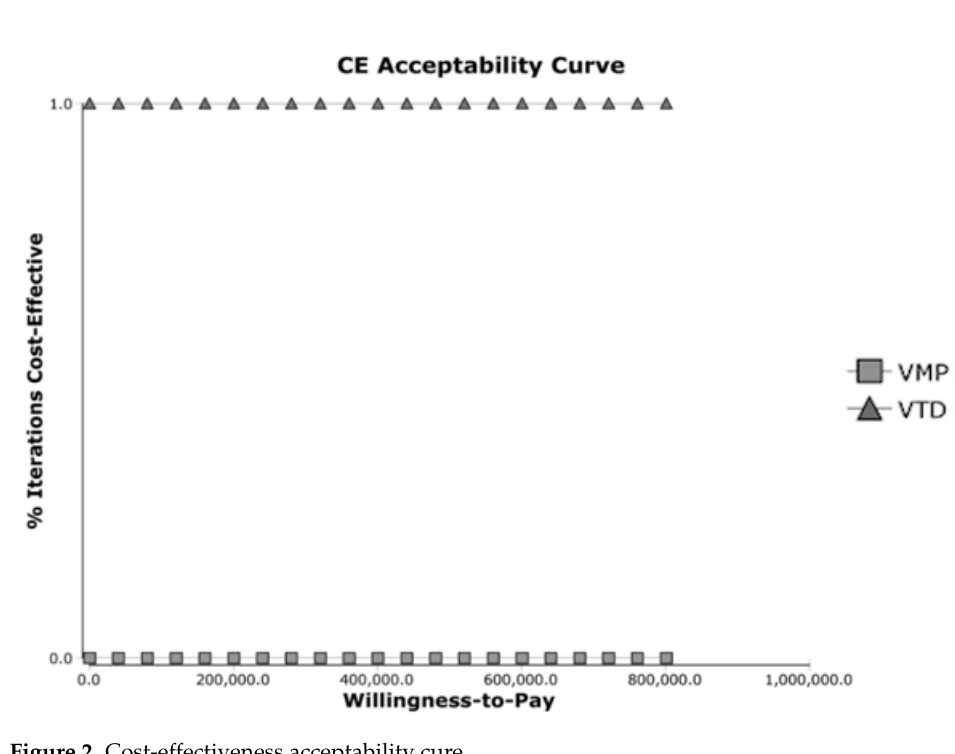
Figure 2. Cost-effectiveness acceptability cure.